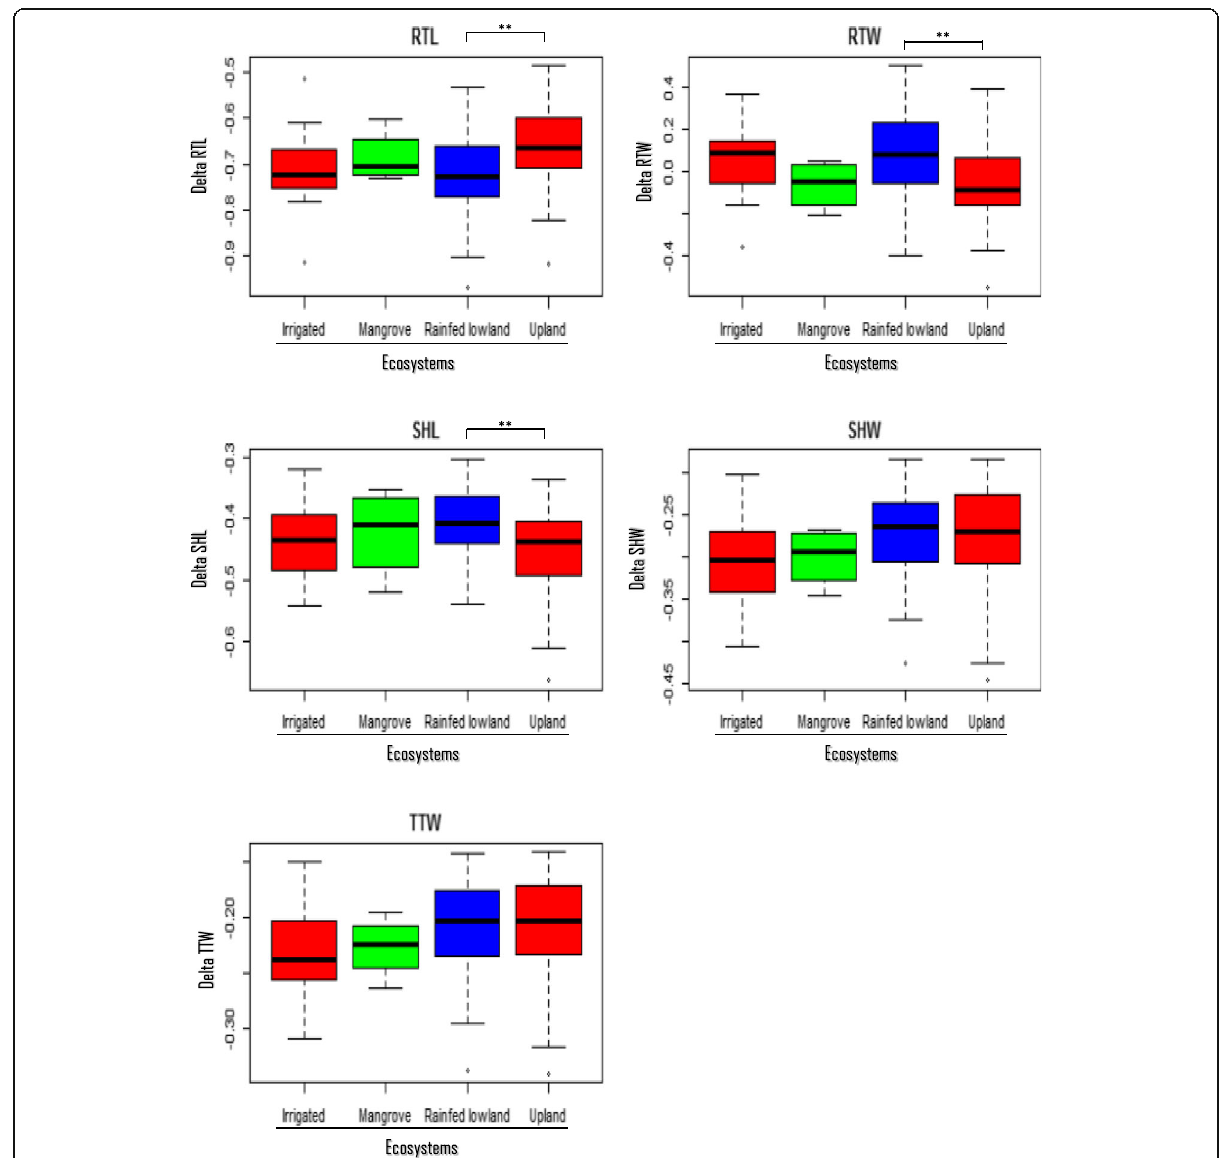
Fig. 4 Phenotypic heterogeneity among ecosystems. The response to JA of rice accessions among four main ecosystems were compared. Student ’ s t- test was used to assess the differences between each couple of ecosystem. The (**) significant is shown with p - values <